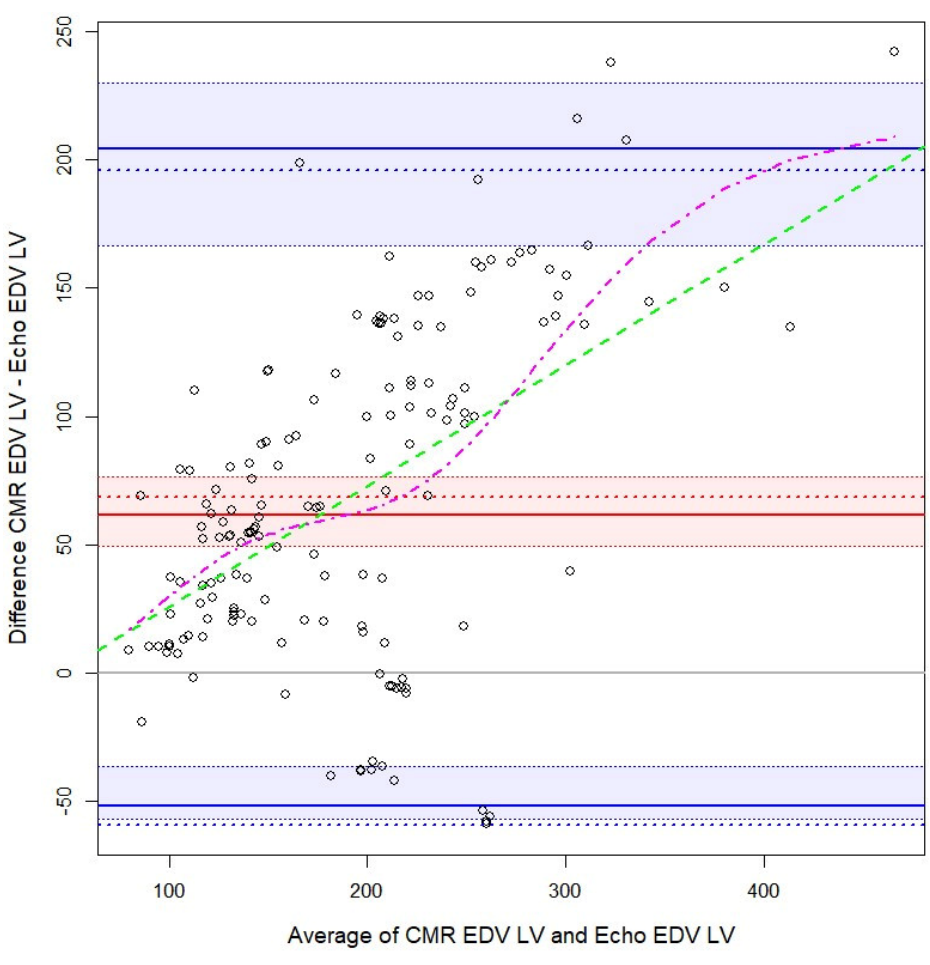
Figure 1. Bland–Altman plot for cardiac magnetic resonance imaging and cardiac echography of left ventricle end-diastolic volume. CMR, cardiac magnetic resonance imaging, EDV, end-diastolic volume; LV, left ventricle; continuous red line, bias as 50th quartile; dotted red line, bias as mean; red interval, 95% bootstrapped confidence interval for 50th quartile; straight blue lines, limits of agreement at 2.5th and 97.5th quartiles; blue interval, 95% bootstrapped confidence interval for limits of agreement at 2.5th and 97.5th quartiles; dotted blue lines, limits of agreement at 1.96 standard deviations from the mean; dashed green line, linear regression line; magenta dot-dashed line, general additive model fit with a spline.